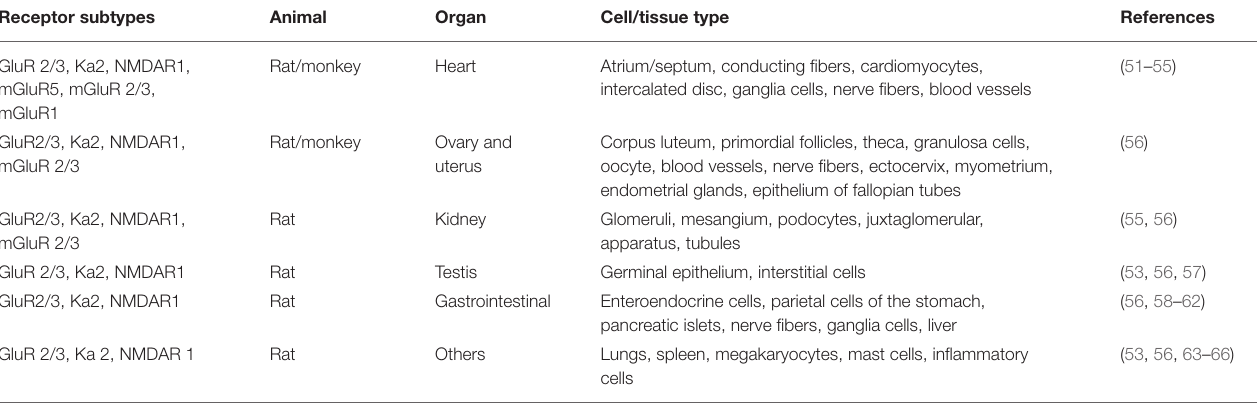
TABLE 1 | Receptor subtypes and their localization.